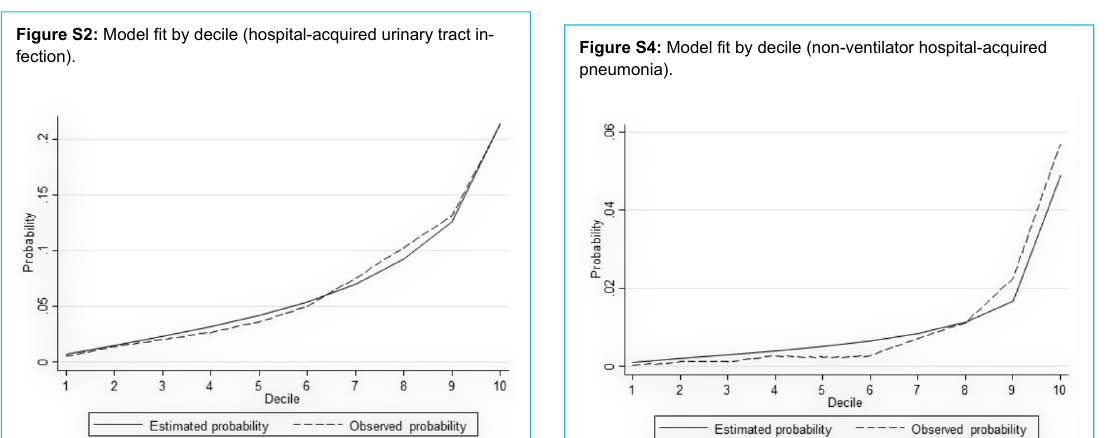
Figure S2: Model fit by decile (hospital-acquired urinary tract in- fection).